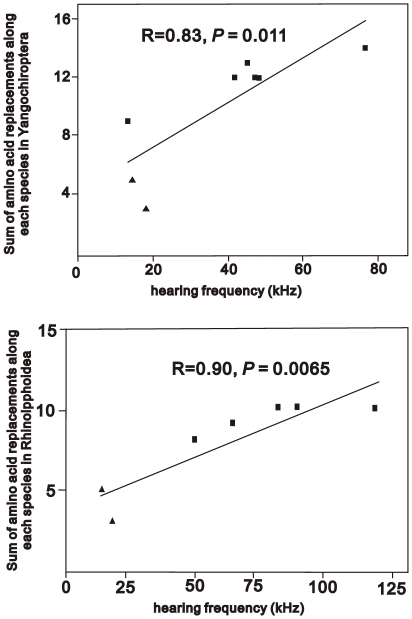
(A) Evolutionary trajectory of parallel sites from prestin and KCNQ4 mapped onto the bat species phylogeny. Red points indicate the nodes where higher frequency hearing might gain. (B) States of parallel-evolved sites from prestin and KCNQ4 on different branches.